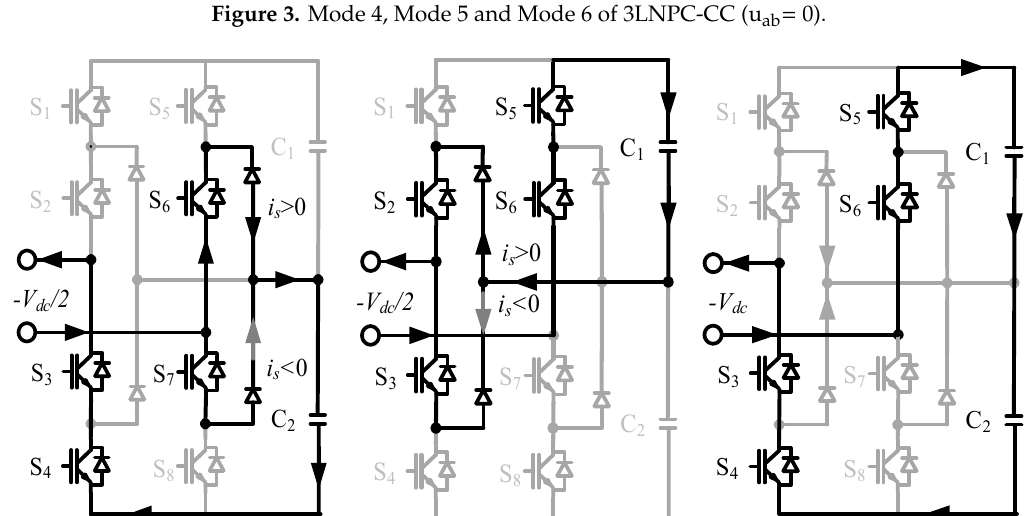
Figure 3. Mode 4, Mode 5 and Mode 6 of 3LNPC-CC (u ab = 0).